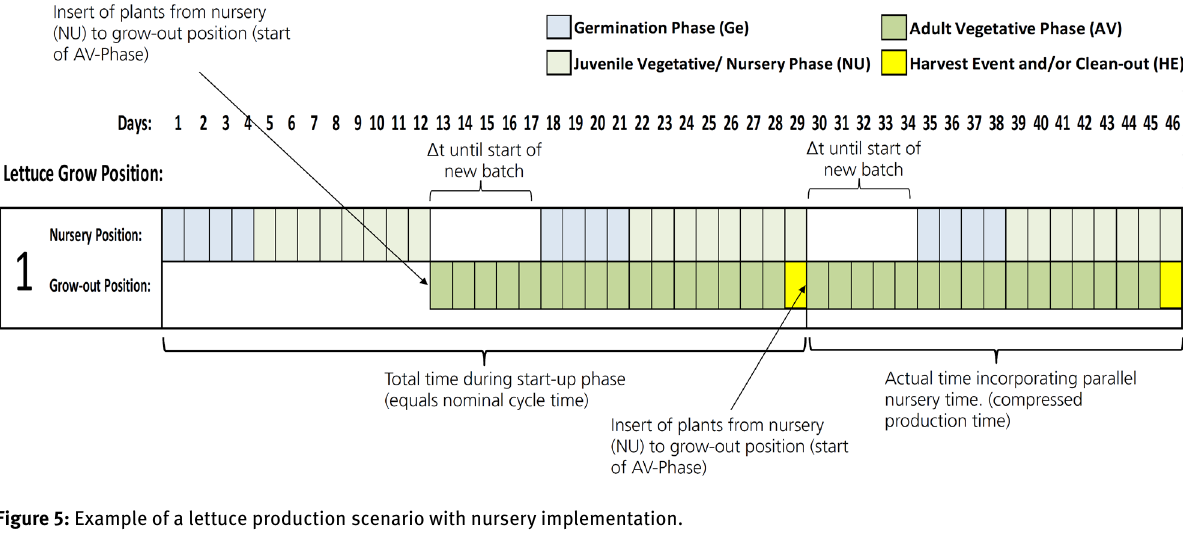
Figure 5: Example of a lettuce production scenario with nursery implementation.